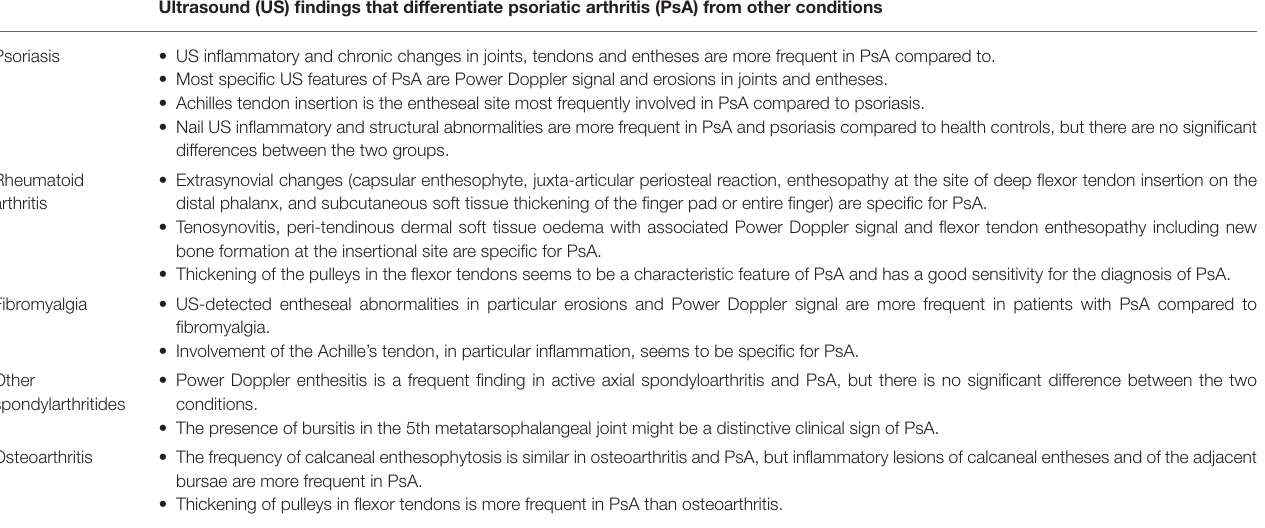
TABLE 1 | Summary of ultrasound findings that differentiate psoriatic arthritis from other conditions. Ultrasound (US) findings that differentiate psoriatic arthritis (PsA) from other conditions